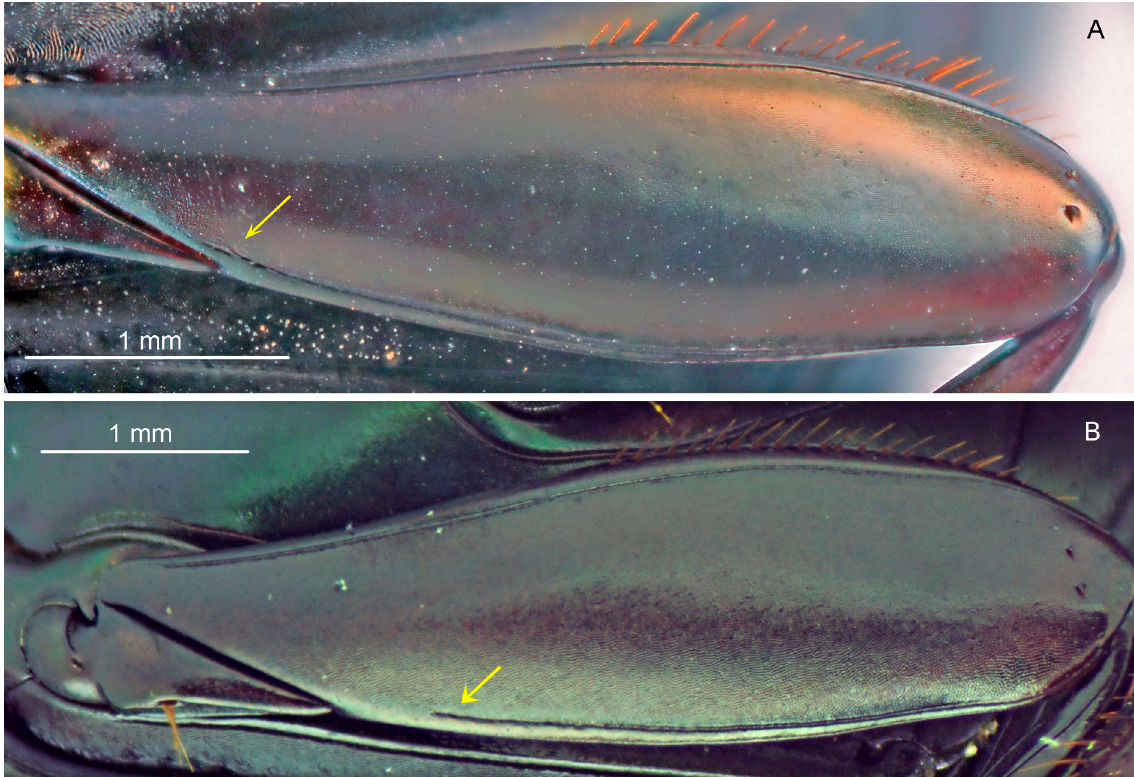
Fig. 31. Metafemora of the two species of the aequinoctialis subgroup. A . Sylvicanthon aequinoctialis (Harold, 1868) comb. nov. B . S. proseni (Martínez, 1949) stat. et comb. nov. Arrow indicates the basal end of the posterior margin of the ventral face of metafemora (note that it is longer in S. aequinoctialis comb. nov. than in S. proseni stat. et comb. nov. and may exceed the trochanter in the first